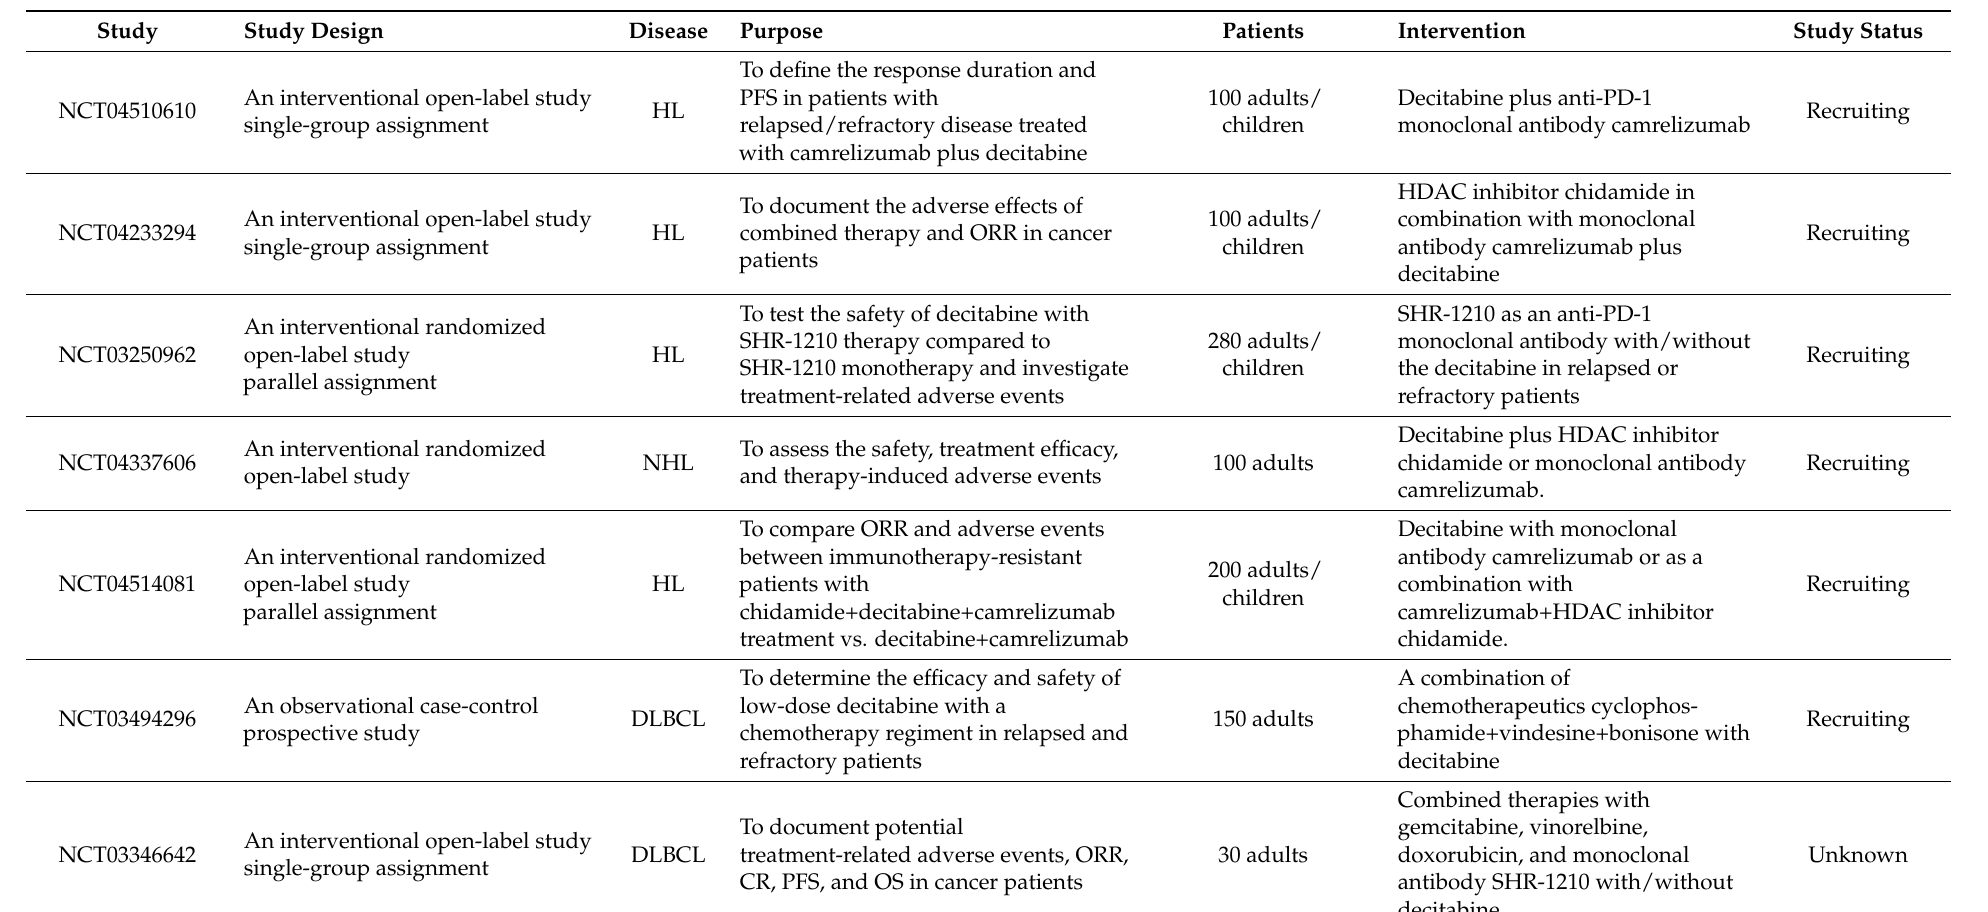
Table 2. The impact of combined therapy with hypomethylating agents and other treatments on the outcomes of lymphoma patients. The table summarizes the list of active and recruiting clinical trials focused on adverse events, treatment efficacy, and survival rates (according to https://clinicaltrials.gov/ and https://beta.clinicaltrials.gov/, accessed on 1 December